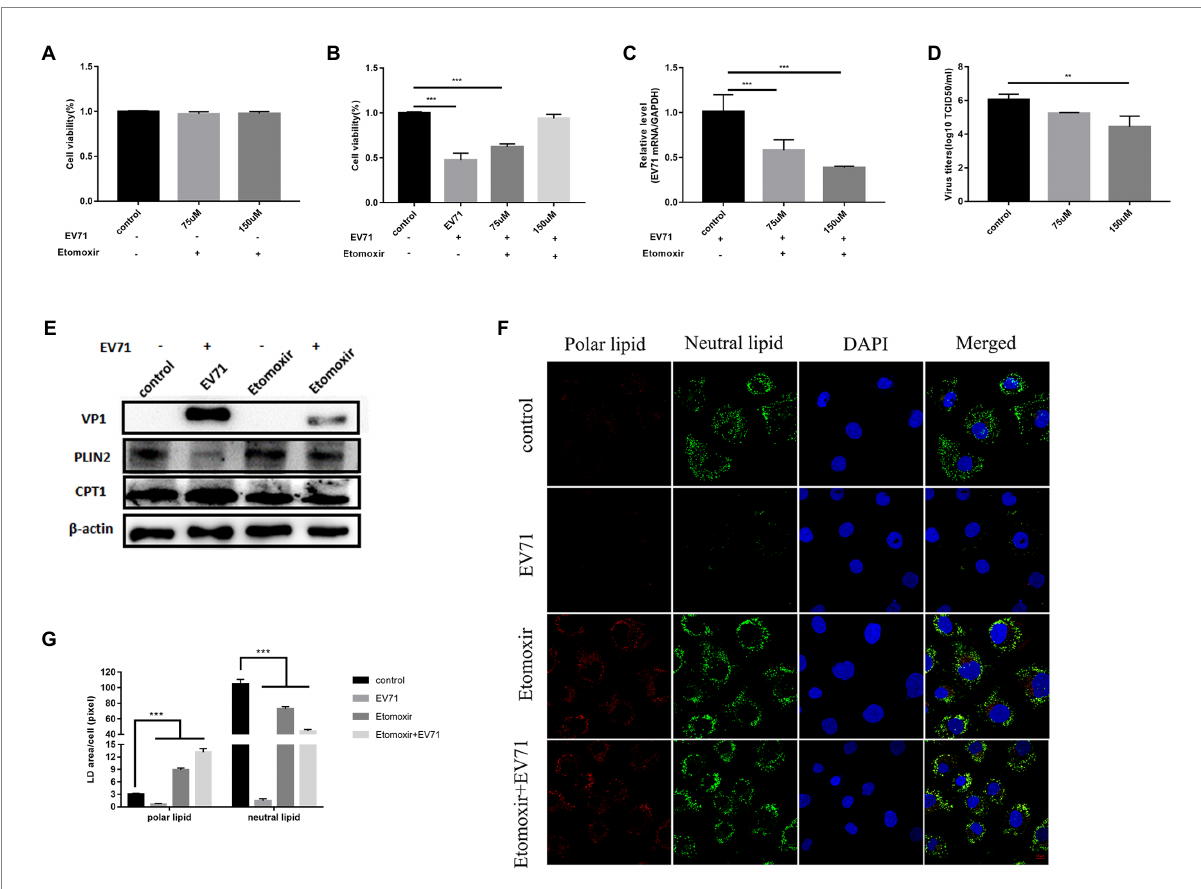
FIGURE 5 Etomoxir inhibits the replication of EV-A71. (A) Cells were treated with 75 μ M and 150 μ M Etomoxir for 12 h. cell viability was detected by CCK8. (B)–(D) HUVECs were treated with 75 μ M and 150 μ M Etomoxir for 12 h and then incubated with EV-A71 for 12 h. (B) The cell viability. (C) The expression levels of EV-A71 gene. (D) The culture supernatant was collected to detect virus titer. The virus titers were 1.73 × 10 5 TCID50/ml and 2.04 × 10 3 TCID50/ml at 75 μ M and 150 μ M. (E) Detection of VP1, CPT1 and PLIN2 protein expression levels. Blank (1st channel), be infected with EV-A71 for 12 h (2nd channel), 150 μ M Etomoxir treated cells for 12 h (3rd channel) and 150 μ M Etomoxir pretreated cells for 12 h and then co- incubated with EV-A71 for 12 h (4th channel). (F) The expression levels of polar and neutral lipid droplets were observed by Nile Red staining. Control (12 h), EV-A71 (be infected with EV-A71 for 12 h), Etomoxir (150 μ M Etomoxir treated for 12 h), Etomoxir+EV-A71 (150 μ M Etomoxir pretreated for 12 h and incubated with EV-A71 for 12 h). (G) The area of lipid droplets per cell was quantitatively calculated. All the experiments were carried out in triplicate. Error bars represent SEM. * means p < 0.05, ** means p < 0.01, *** means p <